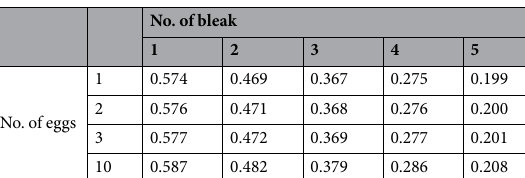
Table 1. Examples of survival probability of individual eggs computed from the logit model for different numbers of bleak ranging from one to five combined with one, two, three and 10 drifting